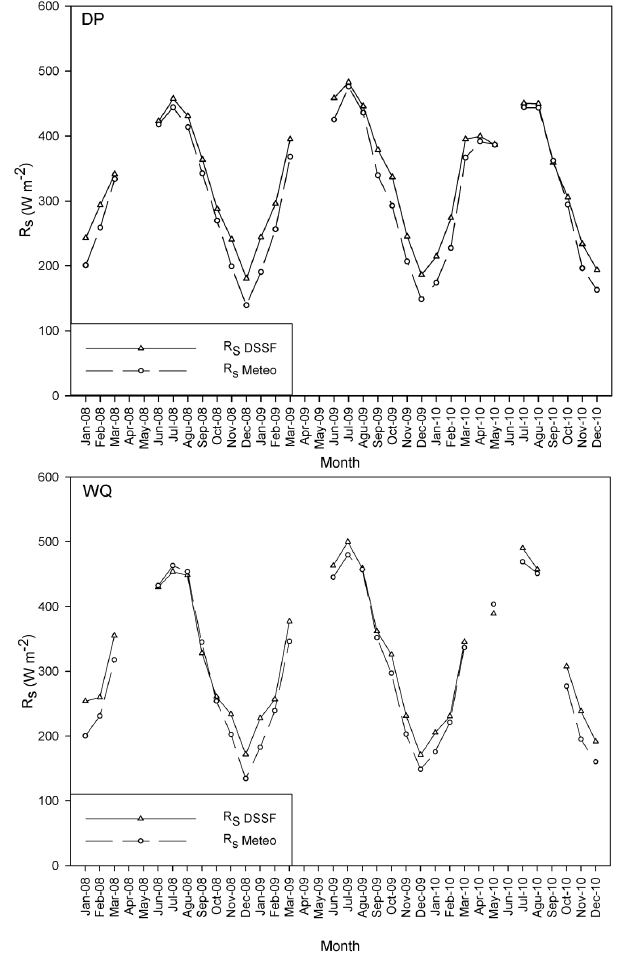
Fig. 6. Examples of monthly DSSF solar radiation ( R s DSSF) and monthly meteorological station solar radiation ( R s DSSF) cycles from 2008 to 2010 at two meteorological stations located in flat conditions (DP) and hilly conditions